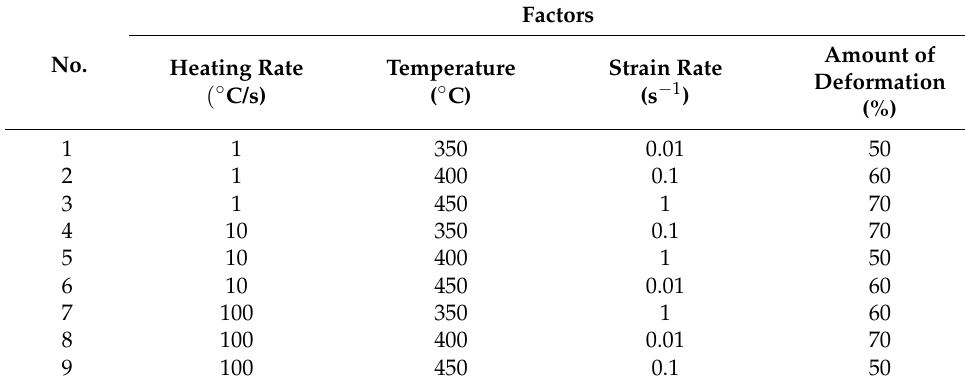
Table 2. Orthogonal experiment table.